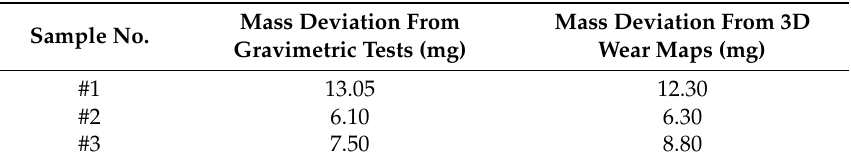
Table 2. Comparison of Results in Test